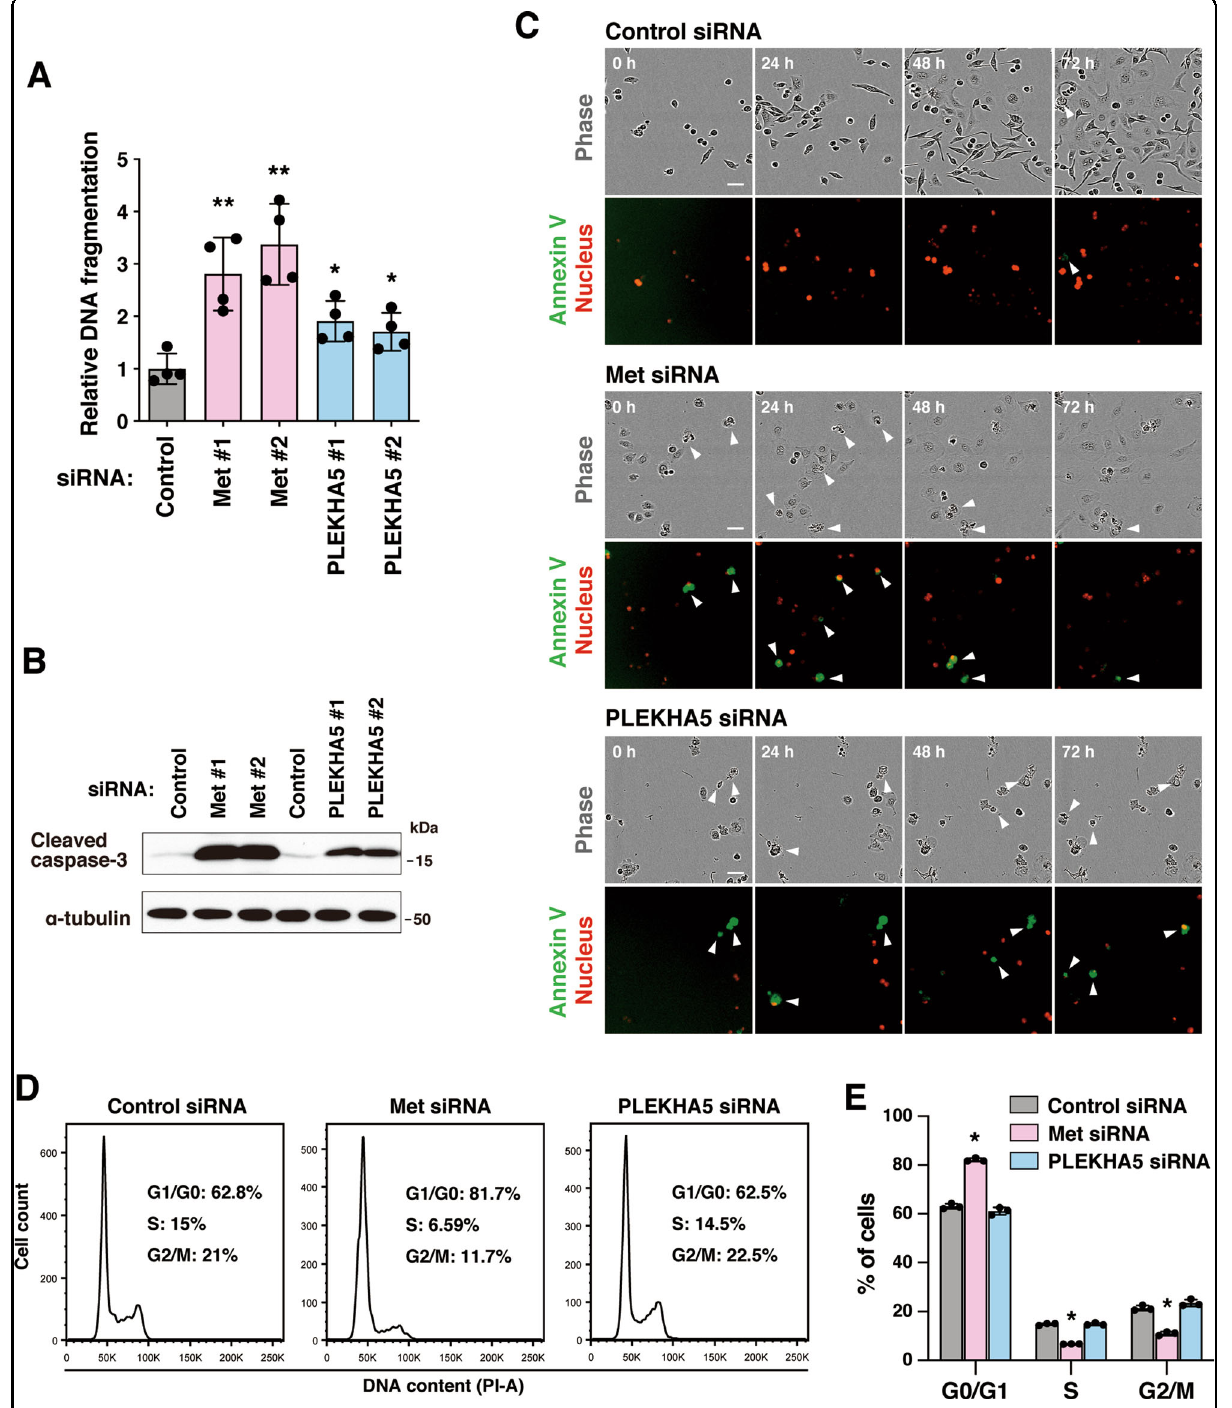
Fig. 3 PLEKHA5 silencing induces apoptosis in Met-addicted DGC cells. A DNA fragmentation in 58As9 cells transfected with the indicated siRNAs. Bars, SD ( n = 4). * P < 0.05; and ** P < 0.01. B The amount of the pro-apoptotic protein, cleaved caspase-3, was examined by immunoblotting. C Image sequences of 58As9 cells fl uorescently labeled for the apoptosis marker annexin V and nuclei were obtained by live-cell imaging. Arrowheads denote the cells undergoing apoptosis. Bars, 50 µm. D DNA content of 58As9 cells transfected with Met or PLEKHA5 siRNA was examined by propidium iodide staining and FACS analysis. E Quanti fi cation of cell populations in each cell cycle phase. Bars, SD ( n = 3). * P < 0.0005.